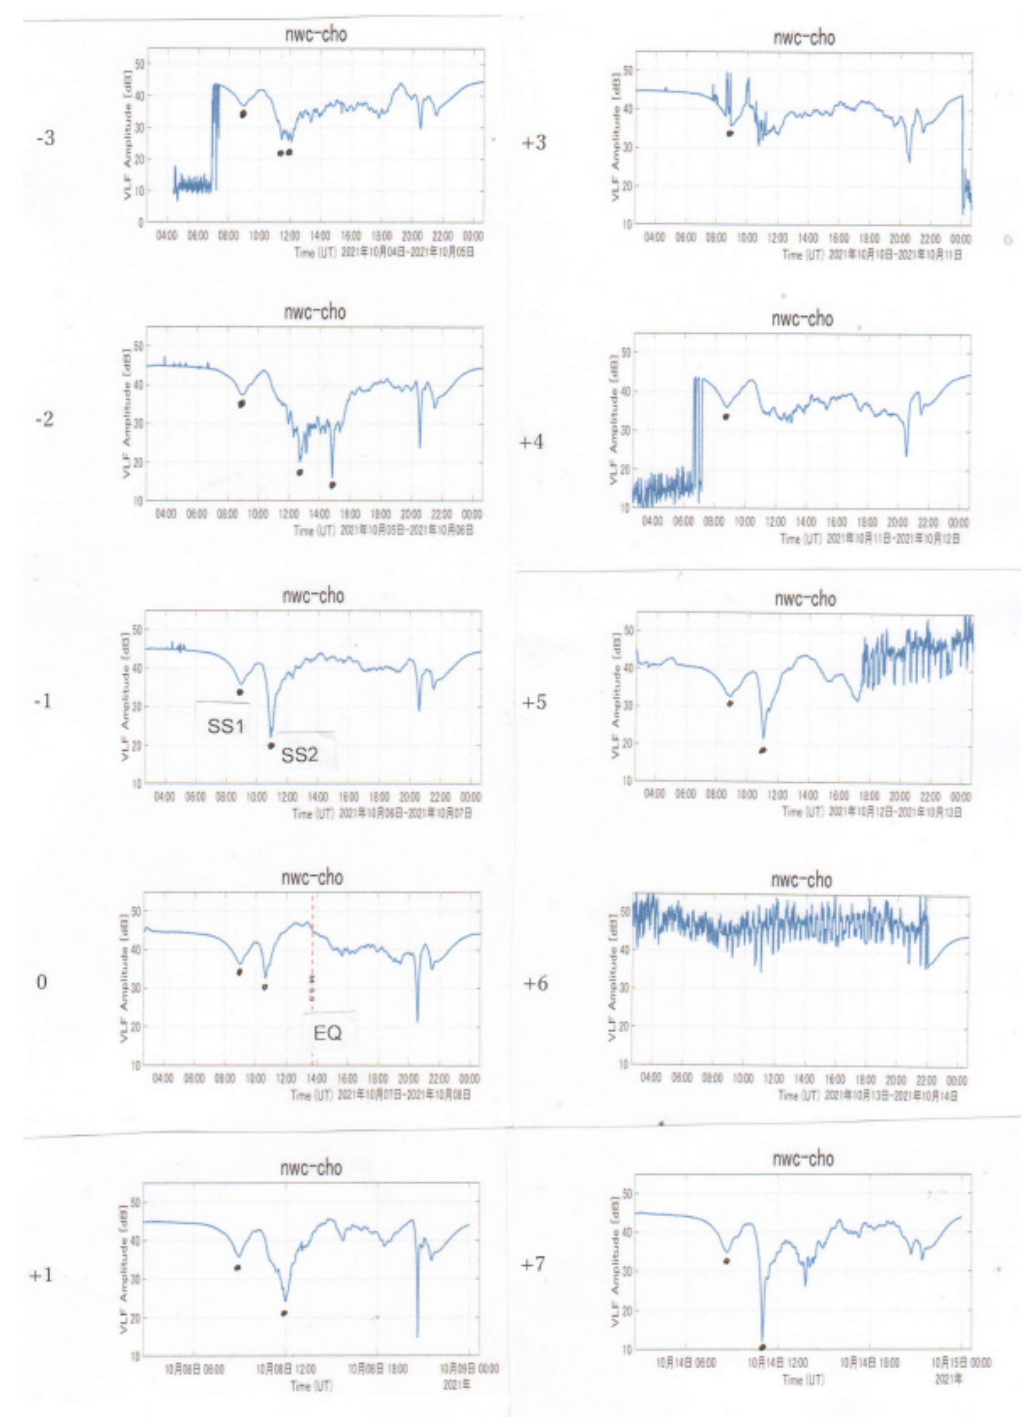
Figure 17. Sequential plots of the amplitude diurnal variations during the period from − 3 days to +7 days of the EQ. Time goes from left top to bottom, then from right top to bottom. The abscissa is UT from 0 h to 24 h. Sunset terminator times as indicated by dots are SS1 and SS2. The EQ time is indicated by a vertical line of EQ in the plot of day